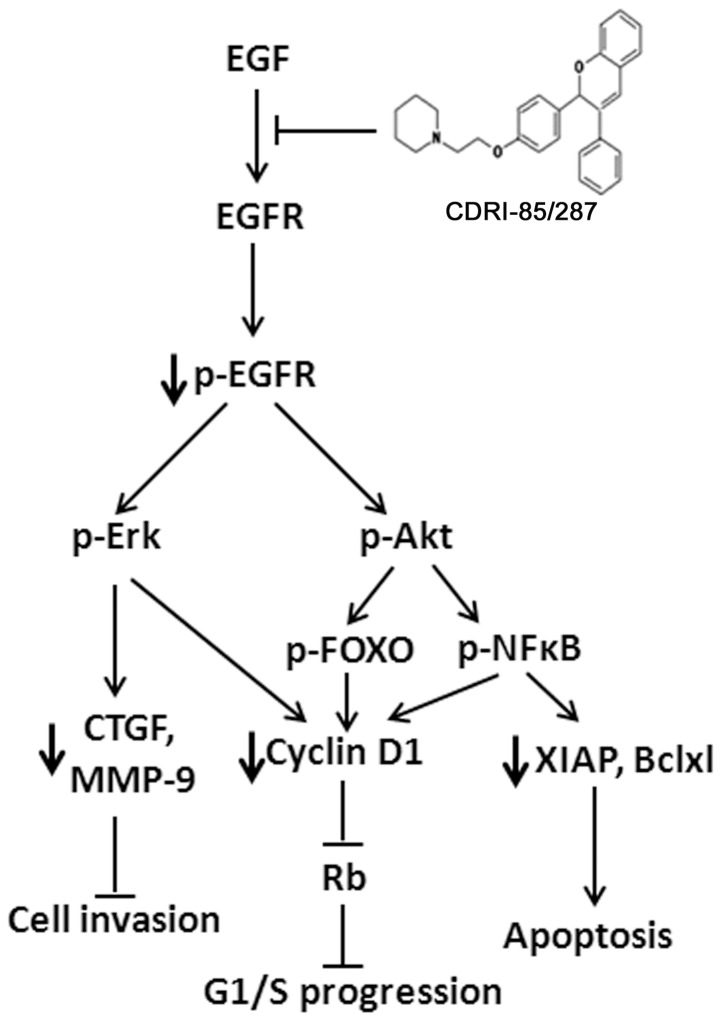
Schematic representation of the action of compound on inhibition of EGFR signaling.The compound competes with EGF in activating EGFR and leads to subsequent induction of apoptosis, inhibition of cell cycle progression and cell invasion.